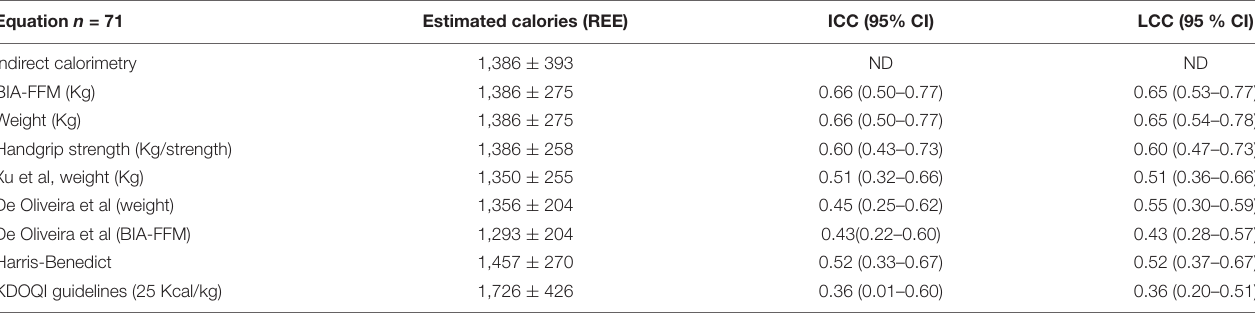
TABLE 3 | Estimated calories and intraclass correlation coefficients between our models, and other authors, with indirect calorimetry measurements.